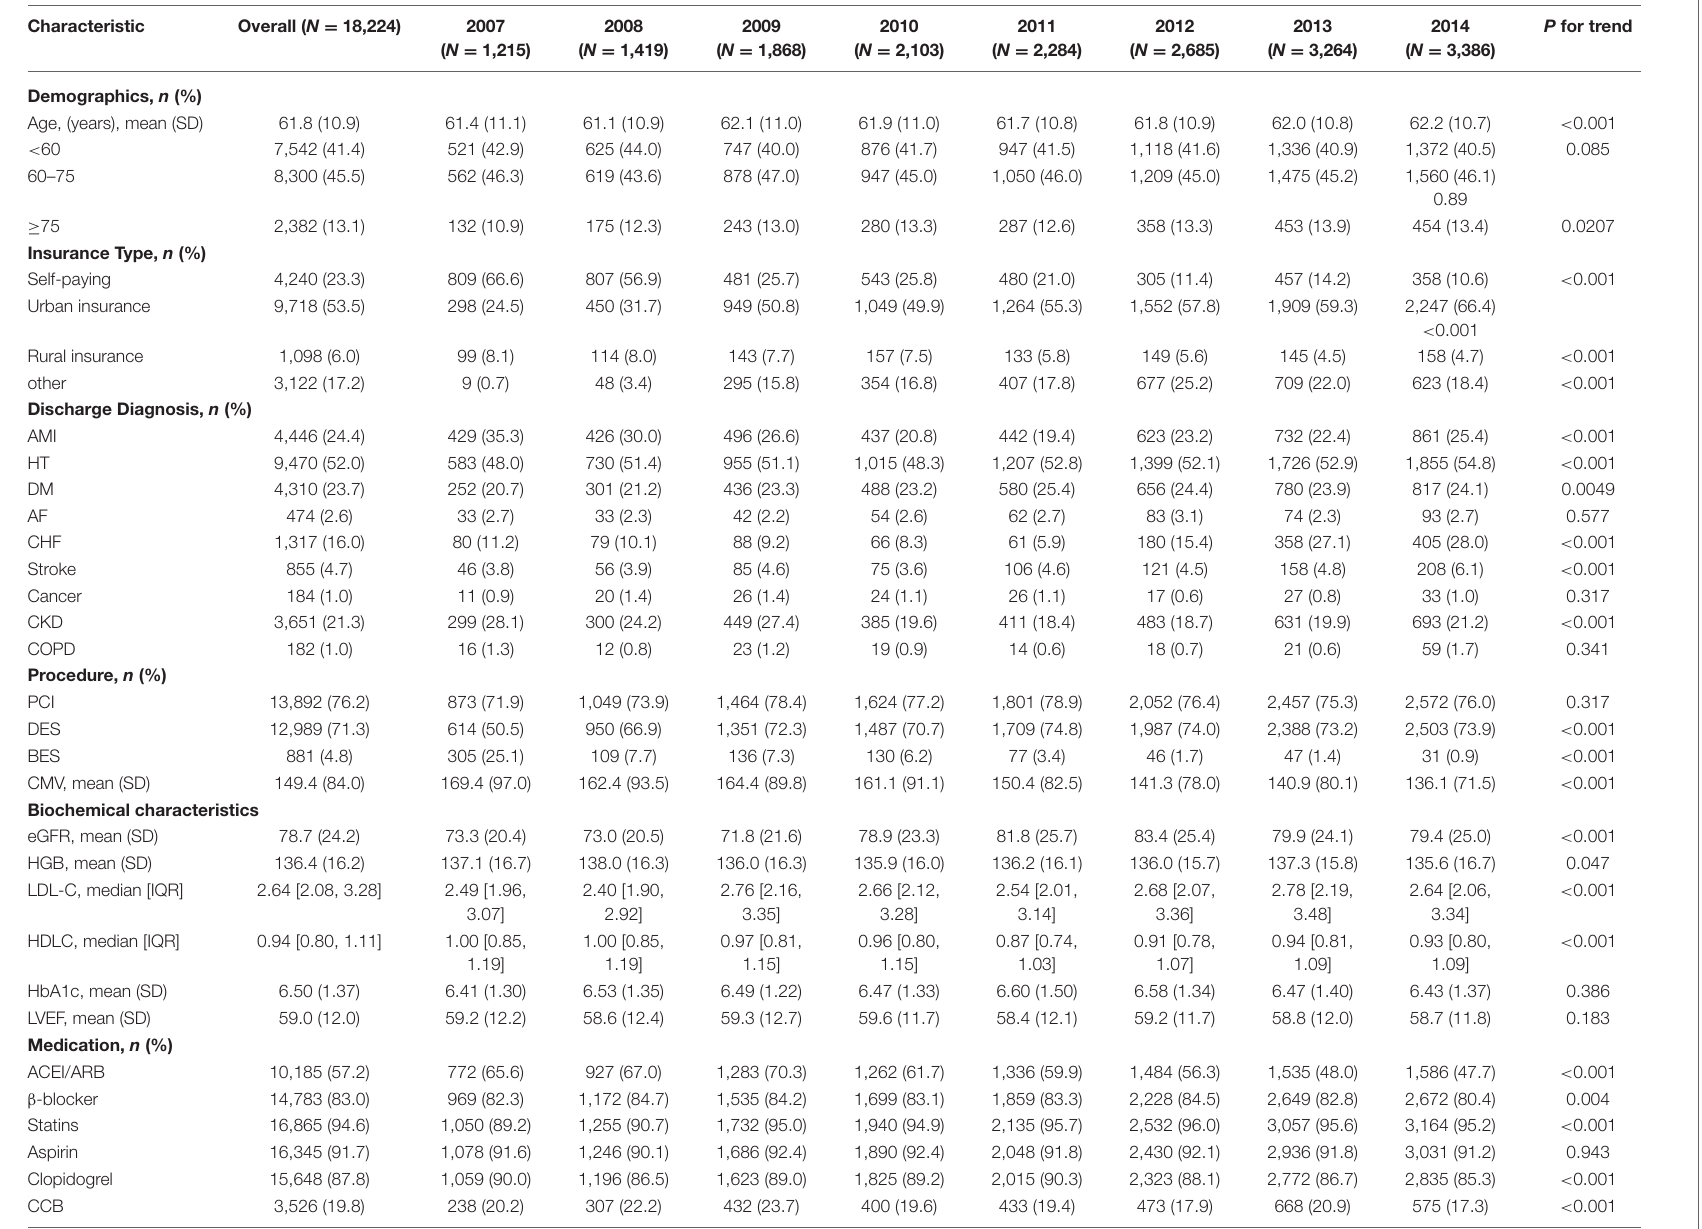
TABLE 2 | Clinical and biochemical characteristics of male patients with CAD from 2007 to